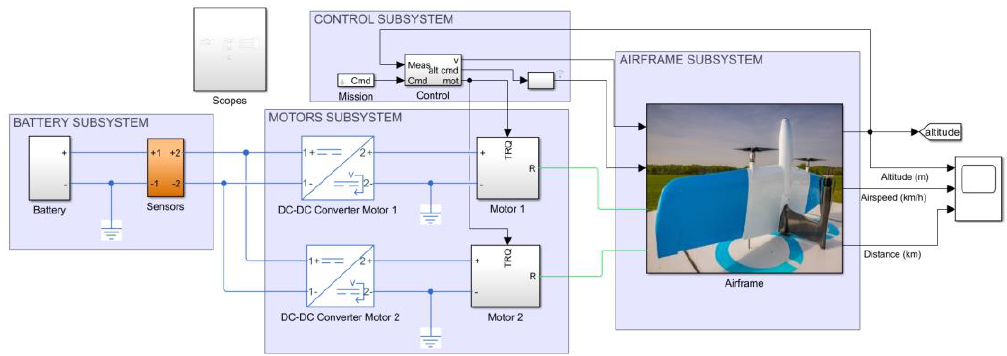
Figure 4. Model for vertical flight simulation.